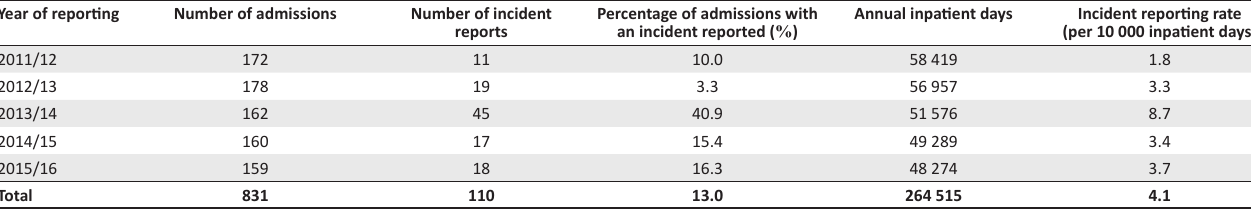
TABLE 1: The annual and overall reported rates of adverse health events at Hillcrest hospital from April 2011 to March